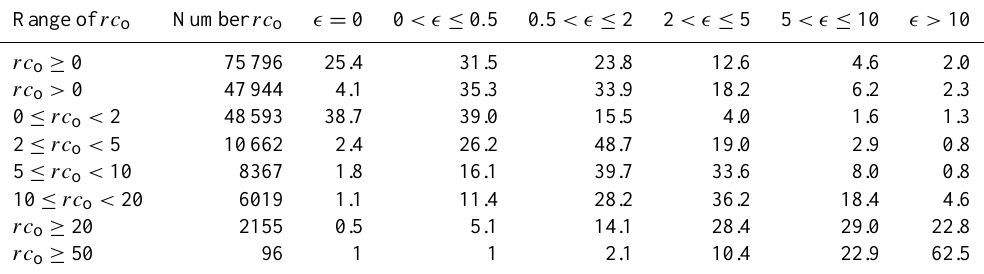
Table 1. Repartition (%) of the absolute errors ( (cid:15) (mm), Eq. 4) across different ranges of observed rainfall ( rc o ) events for the observed data of the Scottish validation gauges, in which days were only retained when the tipping bucket was at least 5km away from any of the daily gauges used to derive the rainfall grids.